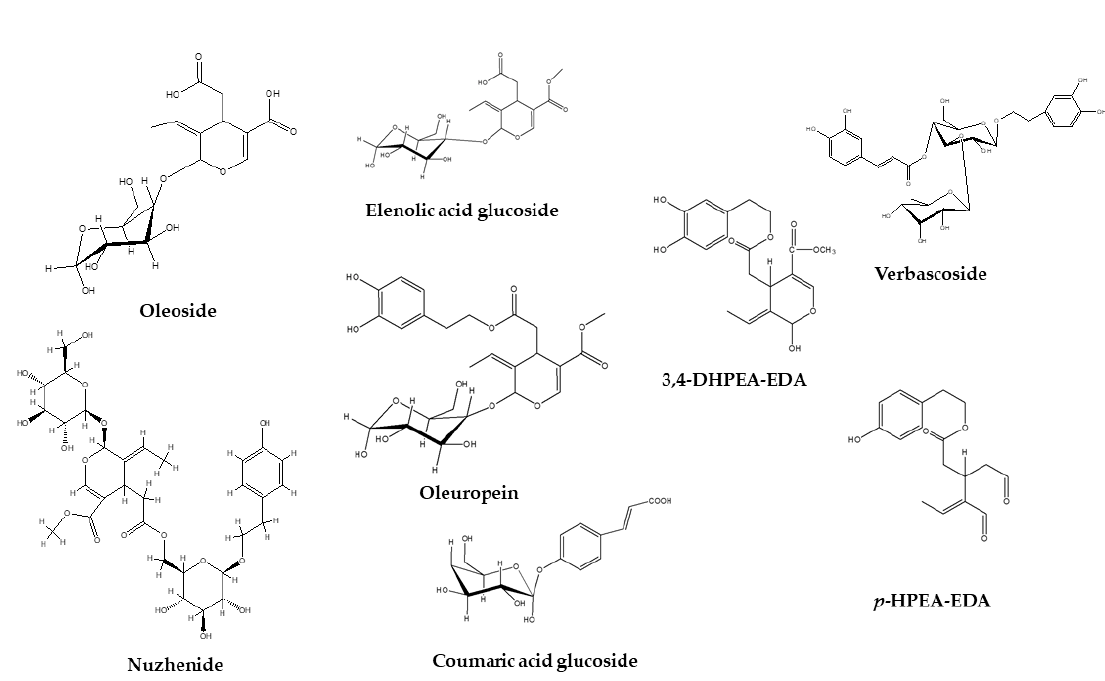
Figure 1. Phenolic compounds identified only in olive pomace and not in olive mill wastewater. Previous reports [19,23,30] have described the presence of four peaks with the exact mass of oleoside, and a fragmentation pattern characteristic for oleoside was found at The mean ± standard deviation, median, minimum and maximum levels of individ- relative retention times 0.92 (peak number 1), 0.96 (peak number 2), 1.00 (peak number ual, total phenolic compounds and different groups of phenolic compounds, such as sim- ple phenolic compounds, benzoic acids, cinnamic acid, flavonoids and secoiridoids, to- gether with the Spearman Rank correlation coefficients between phenolic compounds lev- els and scavenging activity measured using DPPH assay in all pomace samples are shown in Table 1. All results are expressed as mg/kg dry weight (dry wt) of pomace sample. Although from the literature it is well known that the phenolic compound concentrations are affected by agronomic and technological factors, including the cultivar type, ripening stage and geographic origin [6,31], the total amount of phenolic compounds that varied from 851 mg/kg dry wt to 4473 mg/kg dry wt (Table 1) are in the range previously reported elsewhere [14,31]. Podgornik et al. [14], with the same extraction and detection method, determined that the total phenolic compounds range from 500 to 8000 mg/kg d.w. The wide variation of phenolic compounds is consistent with the literature, with the highest levels of total phenolic compounds found in samples from the variety “Istrska belica” (two-phase decanter). The main group of phenolic compounds in pomace was secoir- idoids that comprised on average 71 ± 7%, with the 3,4-DHPEA-EDA and oleuropein or oleuroside that are elute at the same time being the most abundant. A previous report determined that 50–70% of the total phenolic content in olive pomace from the same re- gion was attributed to secoiridoids [31]. In contrast to our results, Madureira et al. [39] determined that the major compound present was hydroxytyrosol in extracted and crude pomace from Portugal. This might be due to both differences in the cultivar types screened and environmental factors in the two studies, which would seem to indicate the im- portance of the evaluation of the phenolic compound content in relation to geographic location and the olive varieties cultivated. In addition, the differences might be due to different post-harvested treatments and storage of the samples. These phenolic com- pounds could have a range of useful applications from use as therapeutic agents to control colorectal cancer [40], to ingredients for the production of fortified food [41,42]. In contrast to a previous report [43], where simple phenolic compounds were determined as the main compounds in pomace, both tyrosol and hydroxytyrosol were present at 8 ± 5% of total phenolic compounds in the samples analyzed for this study. The low amounts of simple